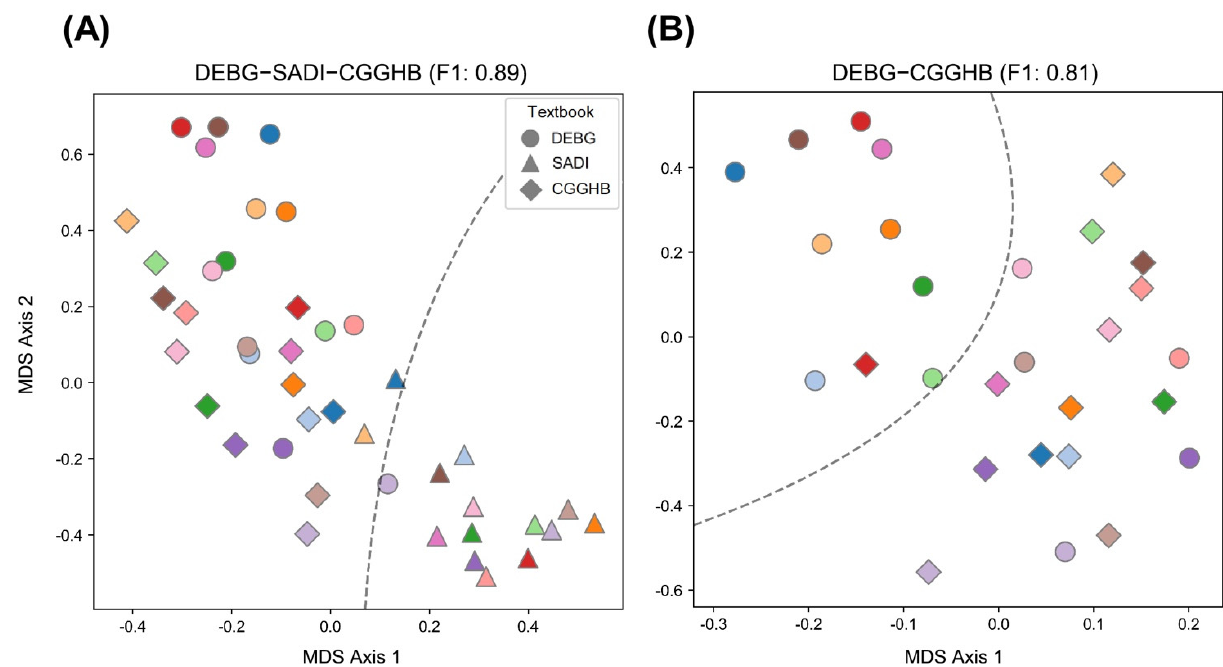
Figure 3. Visualization of the similarity of the AP attribute-scores and their relationship with the original textbooks and diseases. ( A ) Multidimensional scaling of the AP attribute-scores originated from DEBG, SADI, and CGGHB. Indication of colors are the same as in Figure 2A. The dotted line shows a decision boundary that divides the SADI and the others. ( B ) Multidimensional scaling of the AP attribute-scores originated from DEBG and CGGHB except for SADI. Indication of colors are the same as in Figure 2A. A dotted line shows a decision boundary that divides DEBG and CGGHB. F1 indicates the F1 score of the decision boundary. Note that the decision boundary moderately divides the AP attribute-scores that originated in DEBG from those that originated in CGGHB. All decision boundaries obtained by the figures were computed by applying support vector machines (kernel = radial basis function, C = 10, and gamma = 1). DEBG: Dongeuibogam , SADI: Saamdoinchimgooyogyeol , CGGHB: Chimgoogyeongheombang .